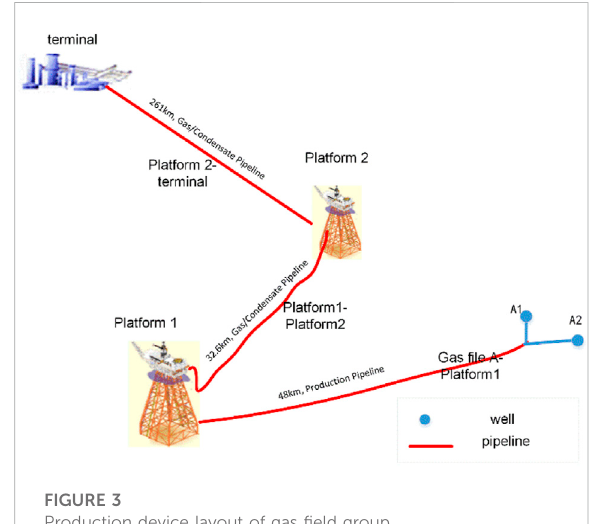
FIGURE 3 Production device layout of gas fi eld group.